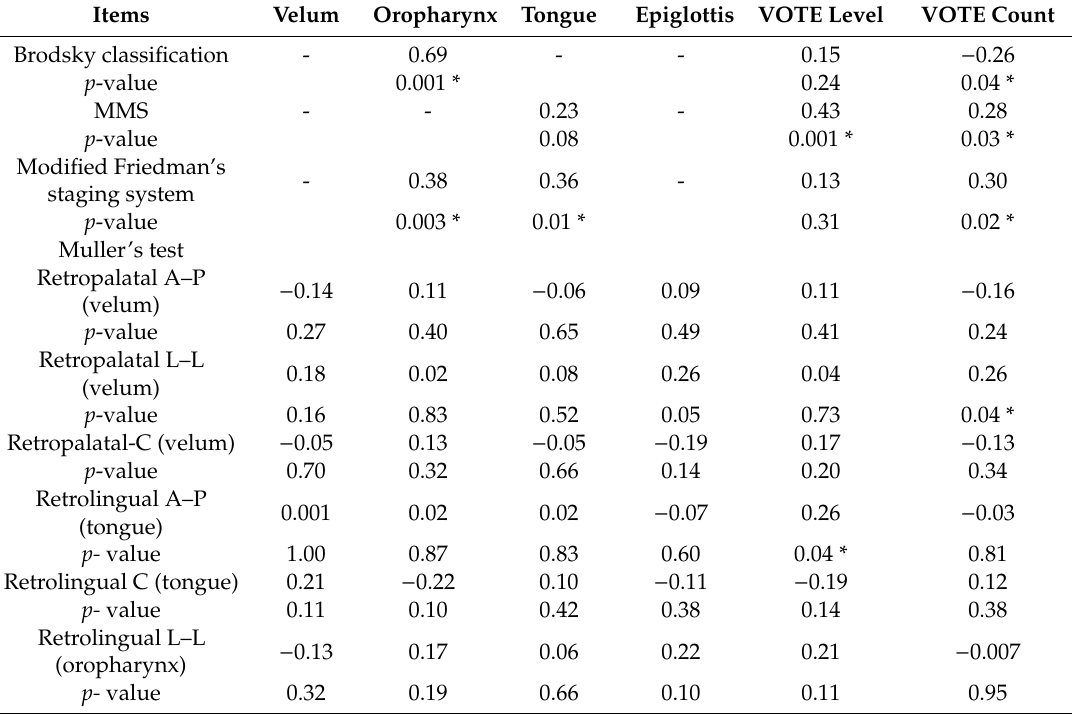
Table 2. Pearson correlation coe ffi cients between physical examination and related VOTE under